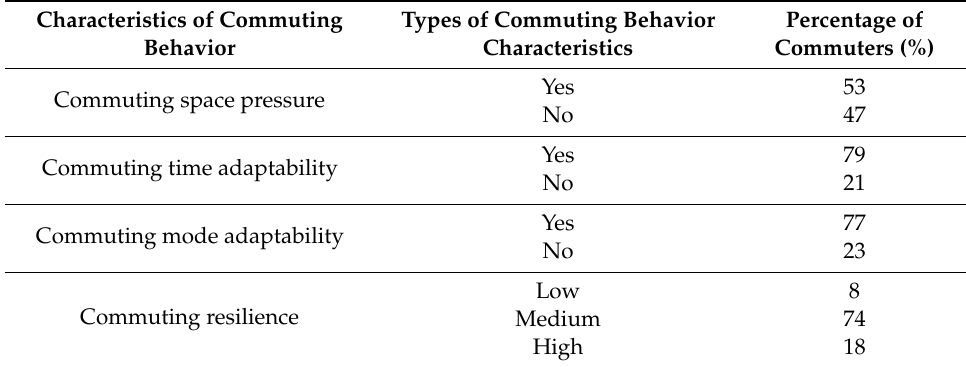
Table 5. Characteristics of commuting behavior from the perspective of resilience